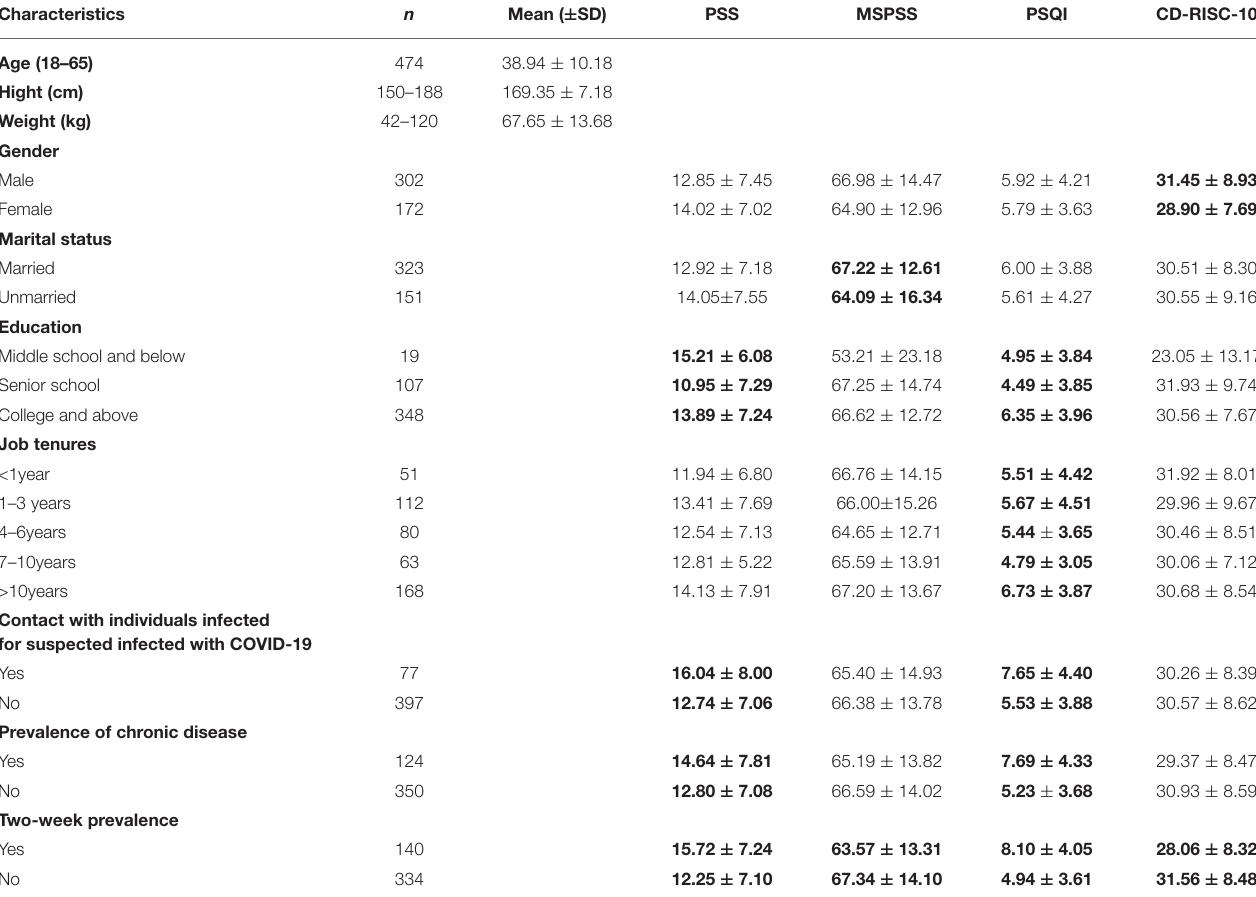
TABLE 2 | Demographics of the